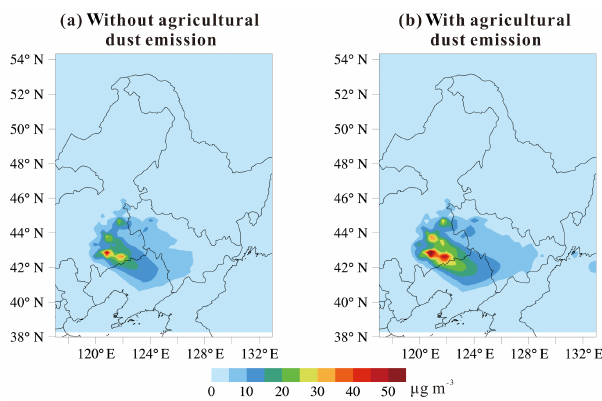
Figure 7. Daily mean PM 10 distributions in NEC on 5 May 2015 without (a) and with (b) agricultural dust emission.